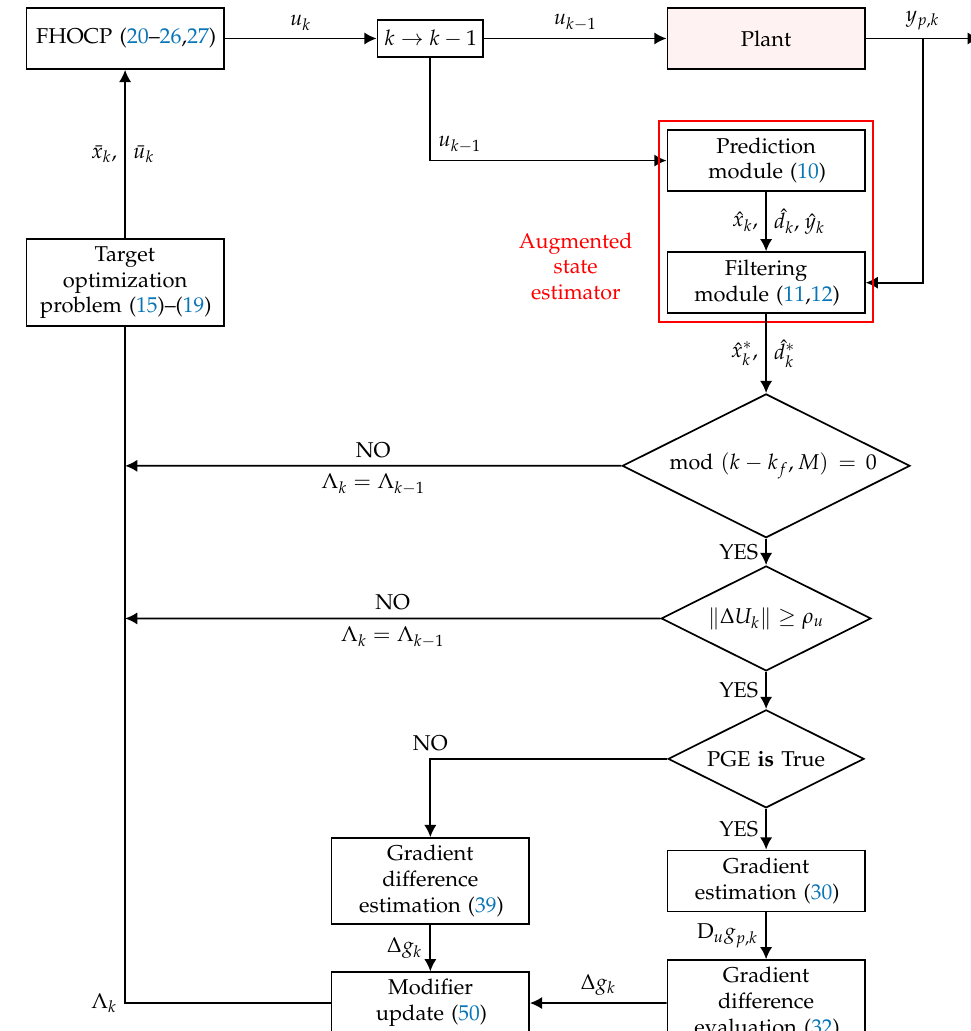
Figure 1. Block diagram for the eMPC algorithm described in Sections 2, 3.2.1, and 3.3.1 using Broyden’s update formula, for k > k f . The acronym PGE stands for Plant Gradient